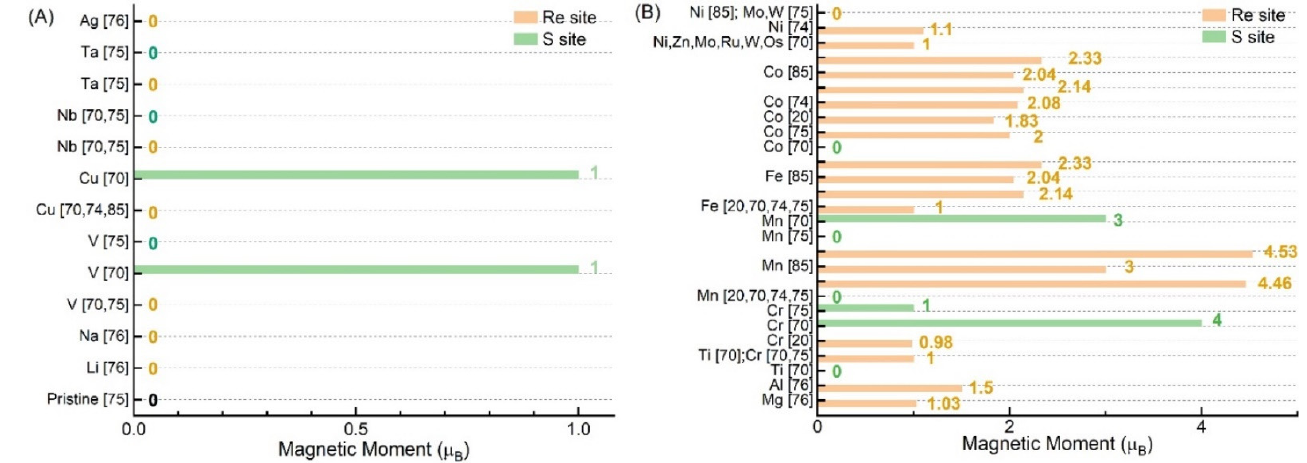
Figure 9. Total magnetic moment of the metal-element doped ReS 2 [20,70,74–76,85]; ( A ) pristine − and doped − ReS 2 supercell at the Re site were still nonmagnetic. ( B ) doped − ReS 2 supercell with one or two atoms exhibited rich magnetic behaviors.